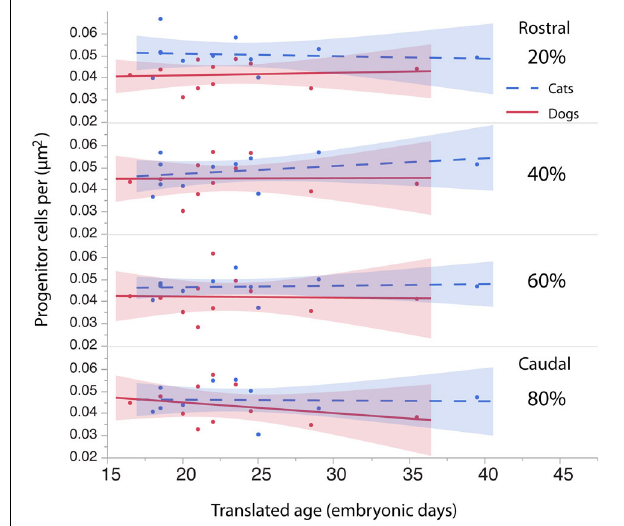
FIGURE 6 | The density of the progenitor cells is regressed against translated age in cats and dogs. The cell density in the rostral region of the cortex (i.e., 20%) in dogs is slightly smaller than it is in cats. The cell density in other regions of the cortex (i.e., 40, 60, 80%) is similar in dogs and